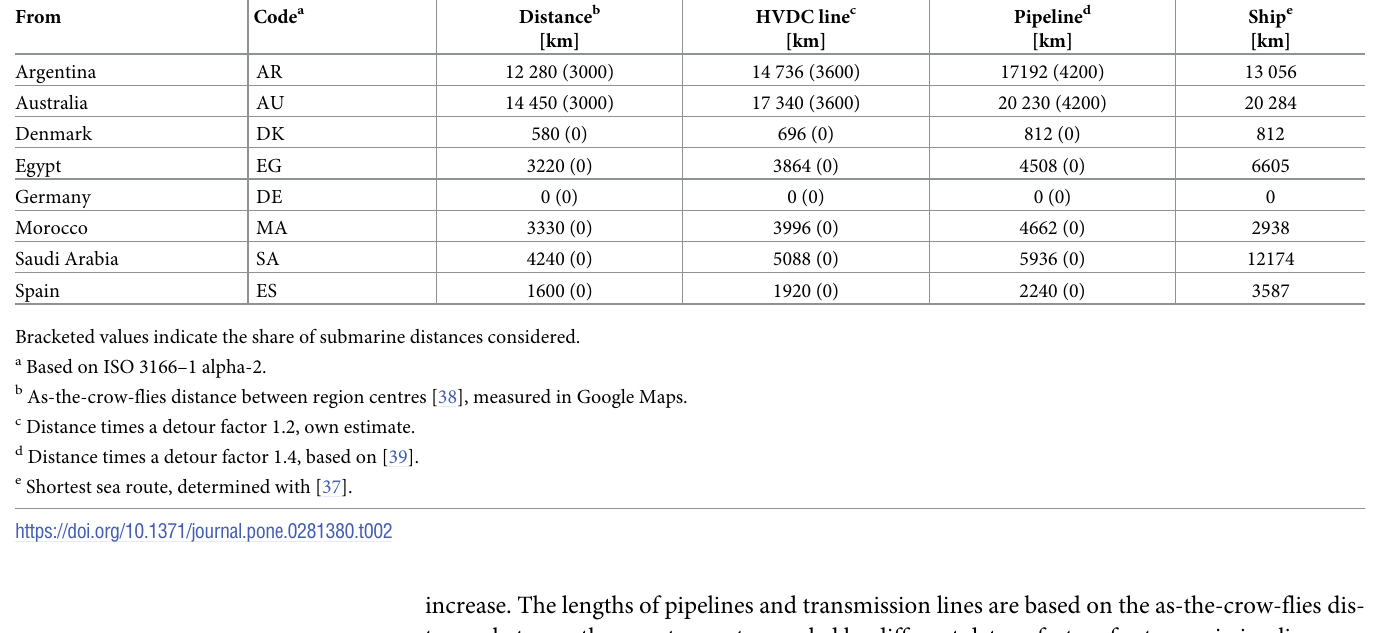
Table 2. Distances between exporting countries and DE assumed for each ESC. From